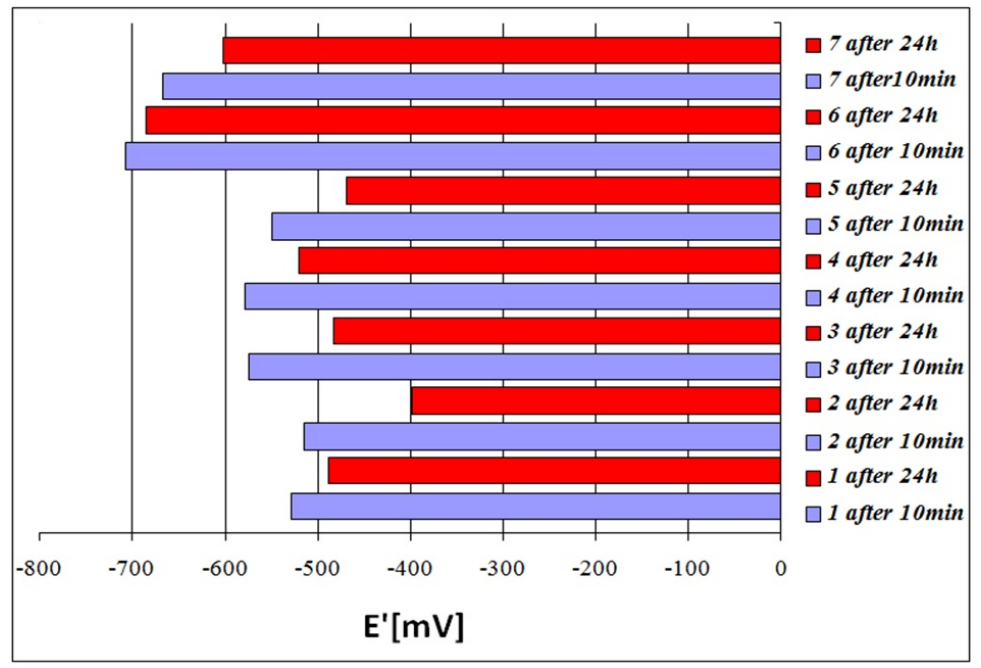
Figure 5. Corrosive potential (E’) of alloys 1 to 7 after 10 min and 24 h of exposure to a 3% aqueous solution of NaCl.